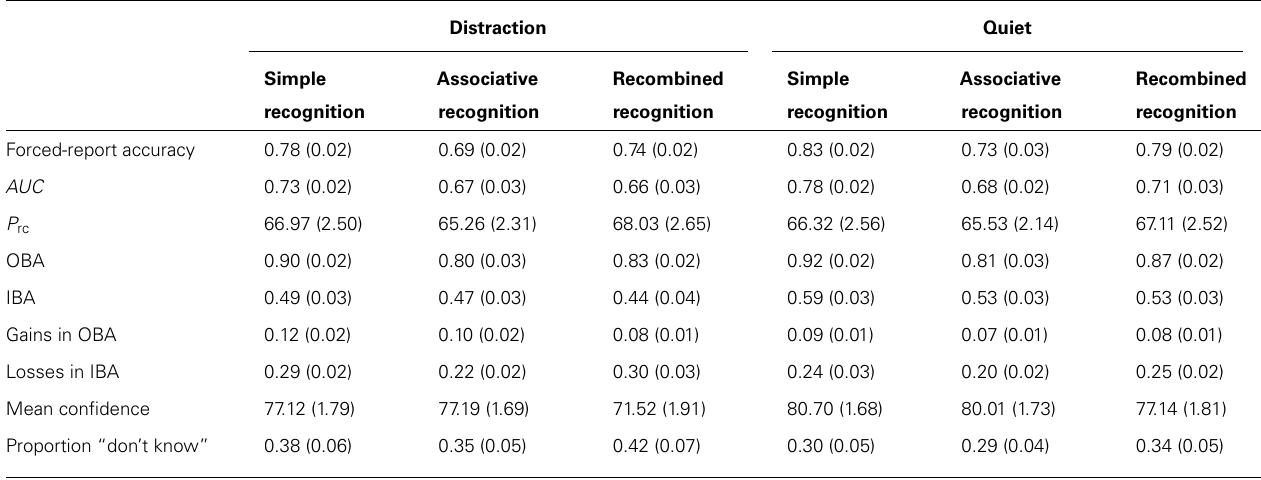
Table 1 |Table showing mean recognition accuracy (hit rate) in the forced-report tests, resolution of metacognitive monitoring (measured by area under the curve, AUC ), report criterion adopted in free-report tests (measured by the P rc measure), output-bound accuracy in